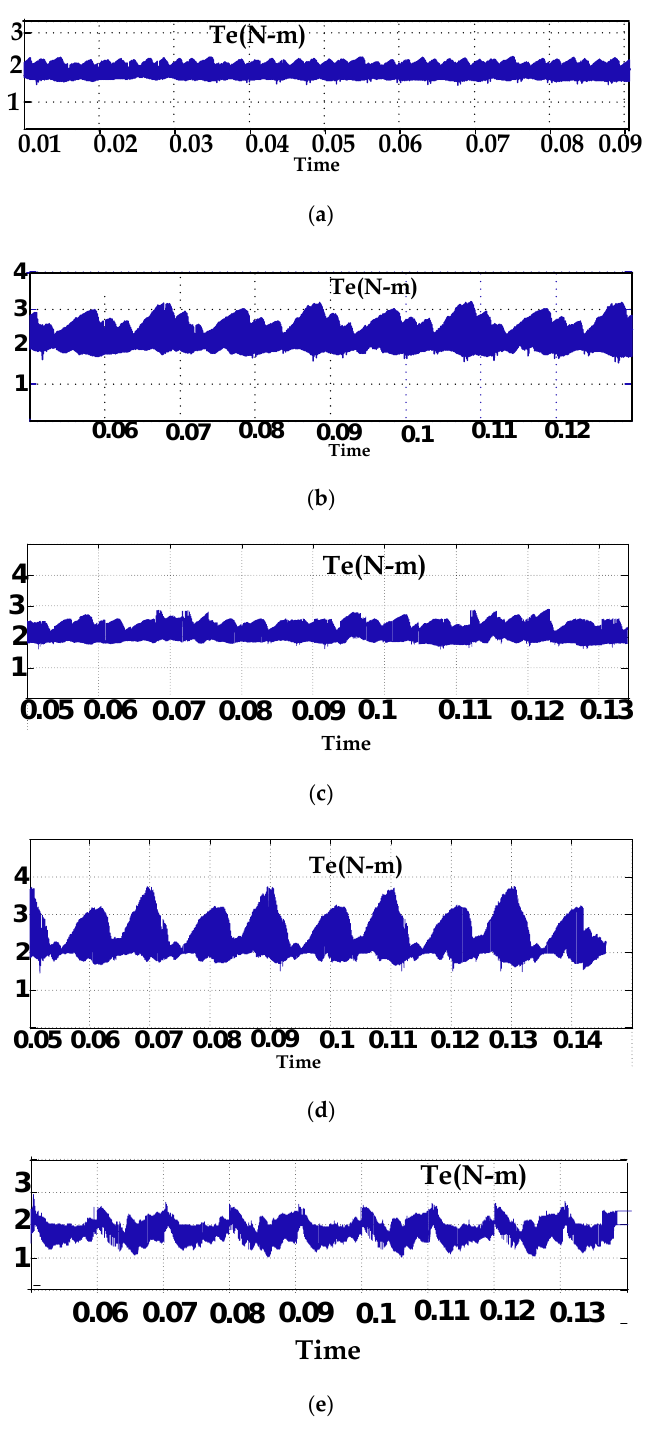
Figure 7. Torque (N-m) under ( a ) Healthy operation; ( b ) 1-Ph open circuit fault without control strategy; ( c ) 1-Ph open circuit fault with control strategy; ( d ) A2-Ph open circuit fault without control strategy; ( e ) A2-Ph open circuit fault with control strategy.